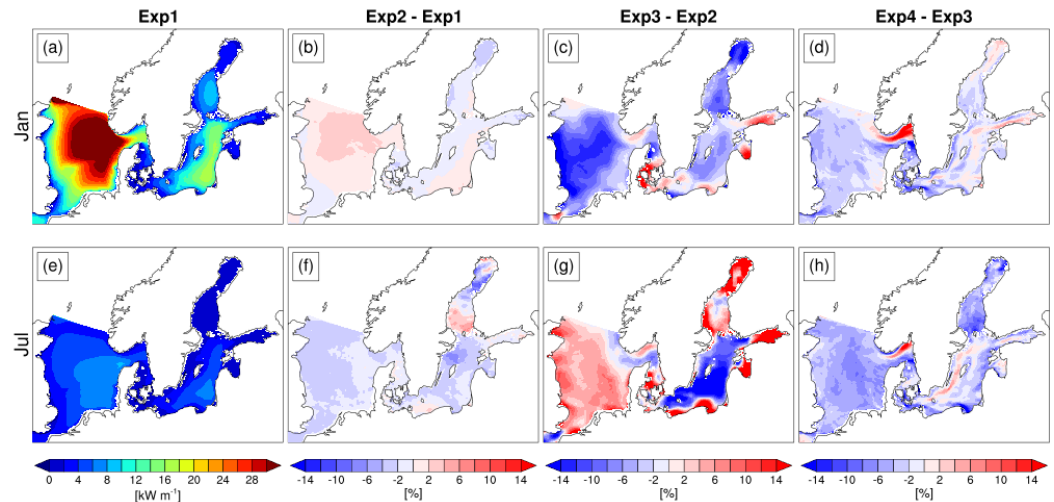
Figure 6. Results for WPE from the different experiments (columns) and the different months (rows) where the top row shows results for January and the bottom row for July (2015). Column 1 ( a , e ) represents the mean WPE from the control experiment Exp1. Column 2 ( b , f ) the influence of wave–atmosphere interaction on WPE (normalized, unit %), i.e., Exp2–Exp1. Column 3 ( c , g ) shows the effect of adding atmosphere–ocean interaction in the simulations of WPE, i.e., Exp3–Exp2 (normalized, unit %). Column 4 ( d , h ) shows the effect of included influence of wave–current interaction when simulating WPE (normalized, unit %).